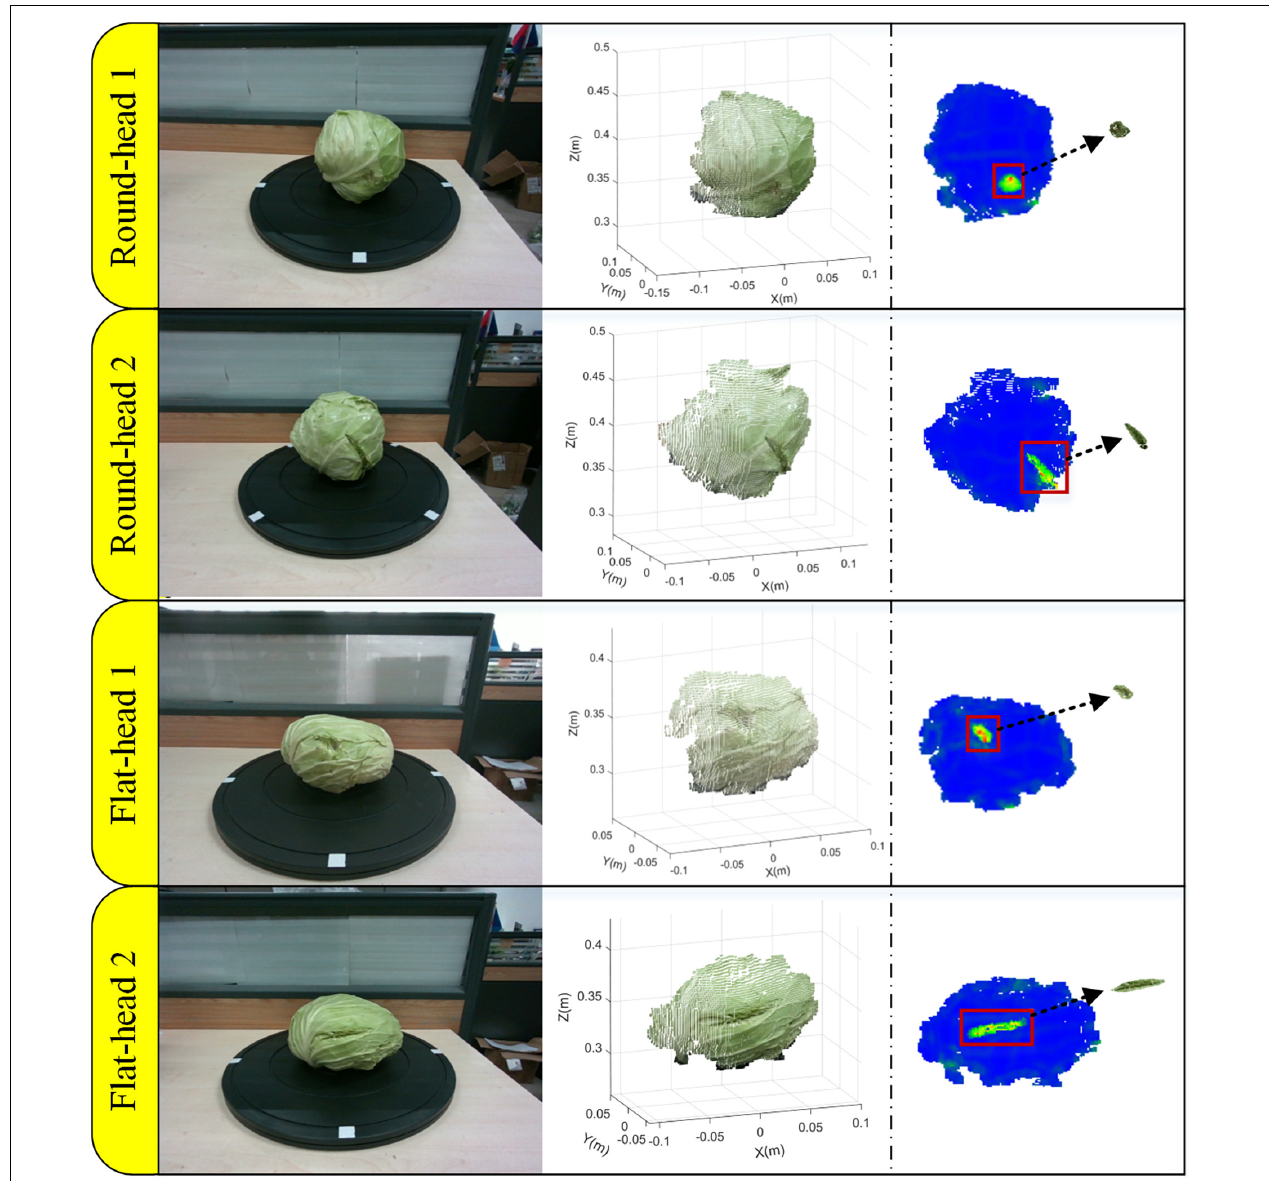
FIGURE 9 | Defective area extraction